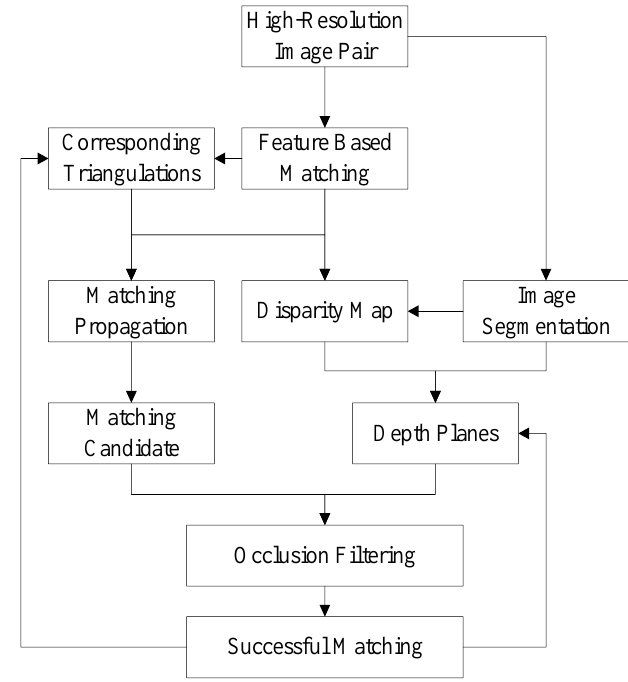
Fig.1 The flowchart of the proposed